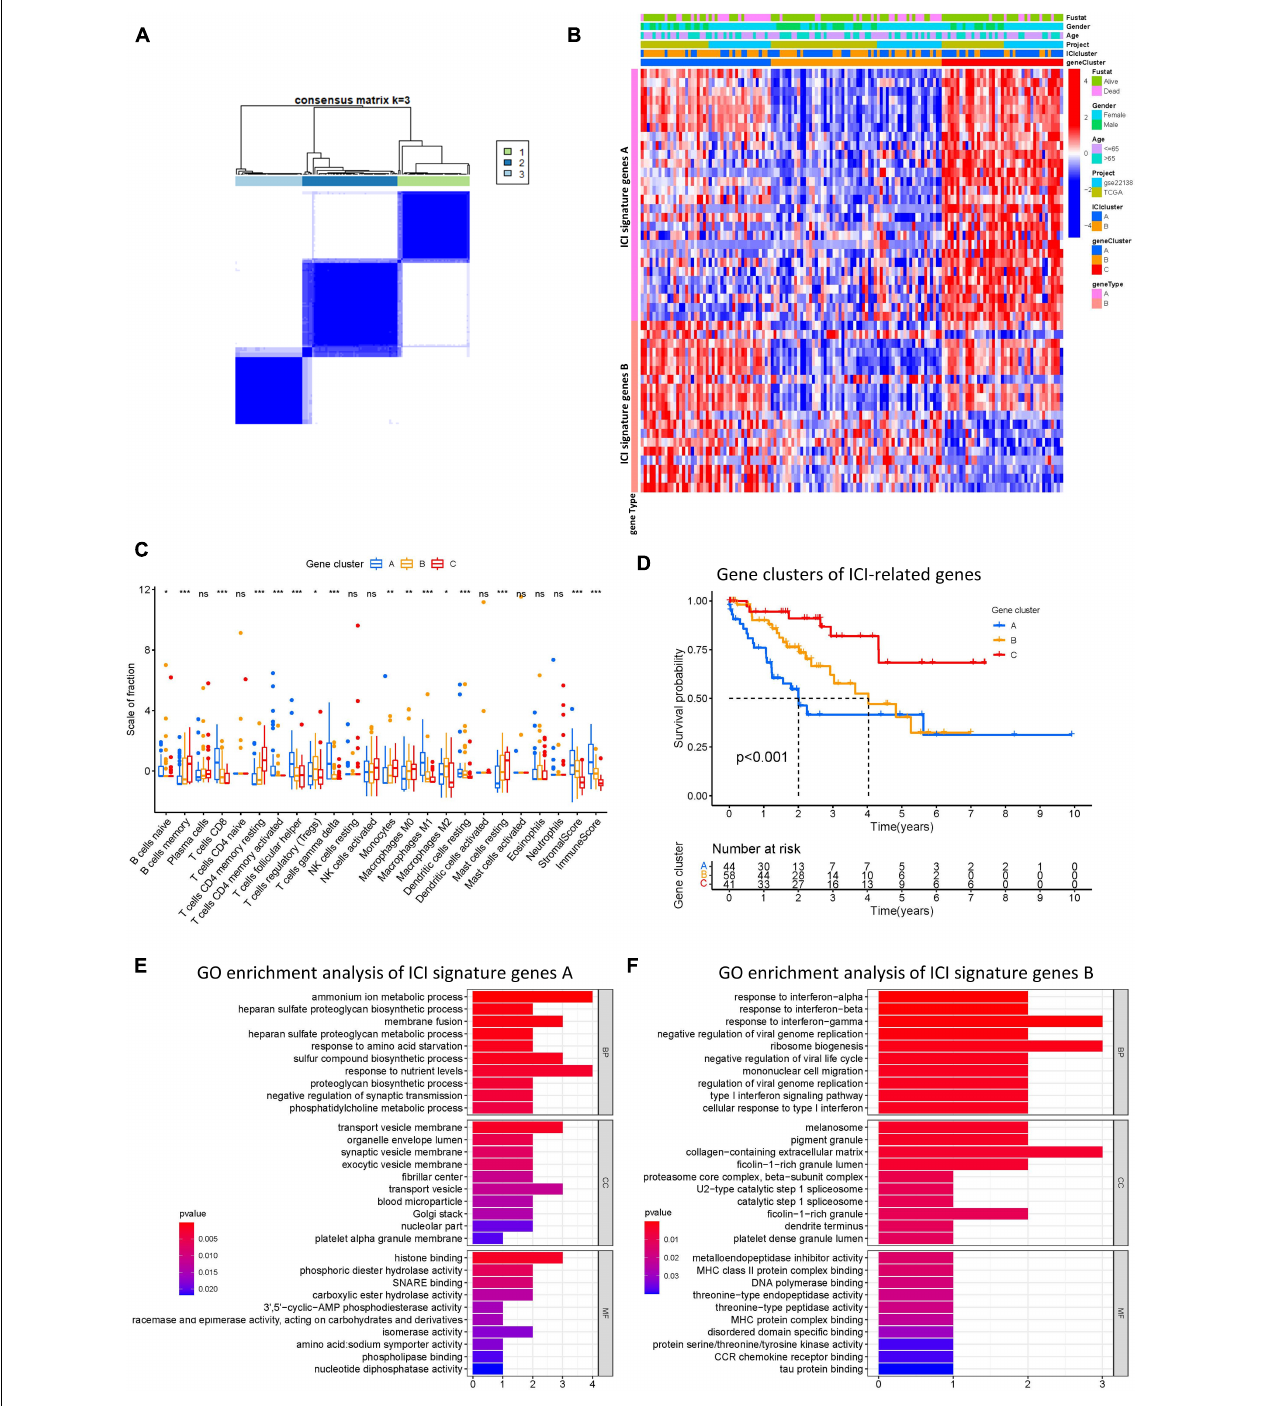
FIGURE 4 | Construction of ICI gene subtypes and functional annotation. (A) Consensus matrix of all UVM cohorts for k = 3. (B) Unsupervised clustering and hierarchical clustering of DEGs among UVM cohorts to classify patients into three groups: Gene clusters A–C. Survival status, genders, ages, project, and ICI cluster group are shown as patient annotations. (C) The fraction of tumor-infiltrating immune cells in ICI gene clusters. We also plotted the immune and stromal scores of three gene clusters. (D) Kaplan–Meier curves for the three gene clusters of UVM patients. Log-rank test shows overall p < 0.001. (E,F) GO enrichment analysis of the two ICI relevant signature genes: ICI signature gene A (E) and B (F) . ns, not significant; * p < 0.05; ** p < 0.01; and *** p < 0.001. ICI, immune cell infiltration; UVM, uveal melanoma; OS, overall survival; GO, gene ontology.